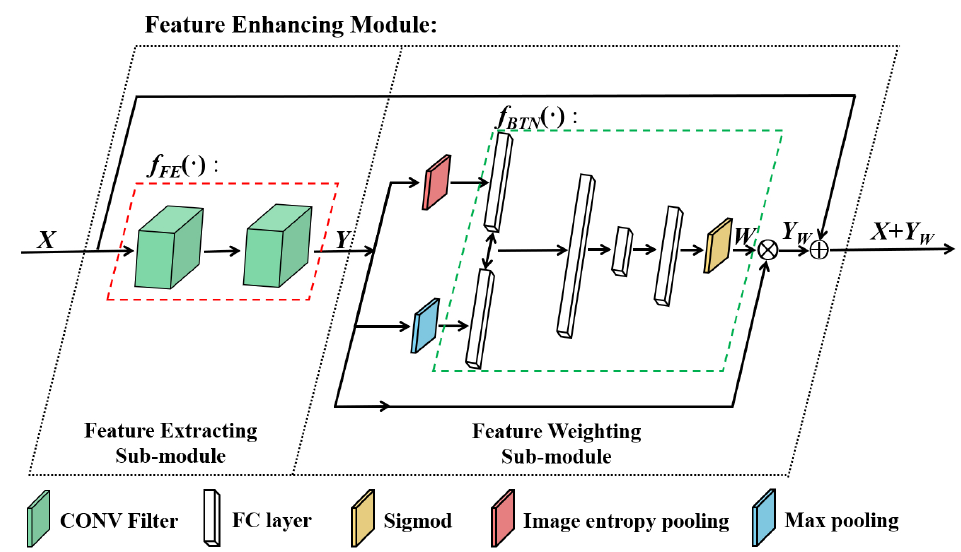
Figure 7. The structure of the feature enhancing